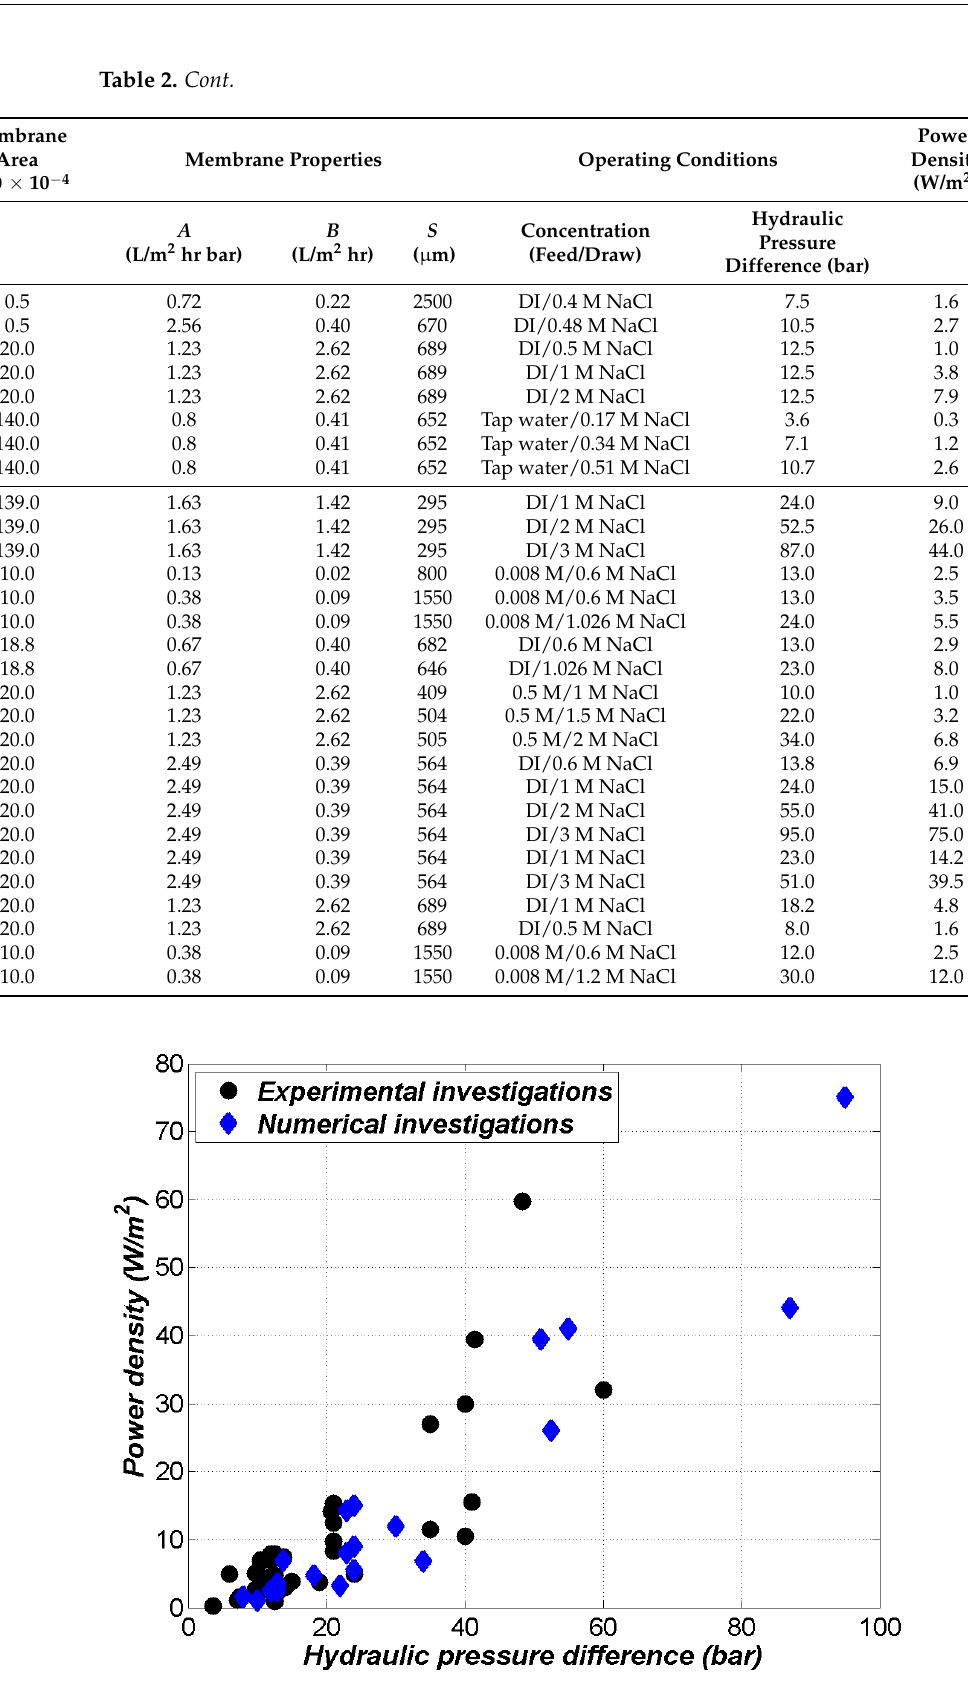
Figure 6. PRO performance from experimental and numerical investigations of a single flat sheet membrane module [25,26,28,38,42,43,53 – 60]. The data used in this figure are summarized in Error! Reference source not found.